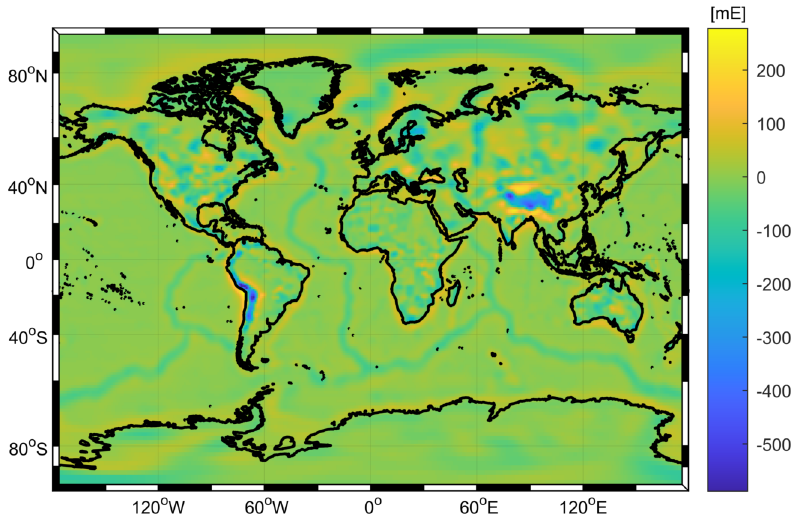
Figure 12. Differences between the forward of the Moho undulation computed applying the F rr ( · ) or (cid:101) F rr ( · ) operator.